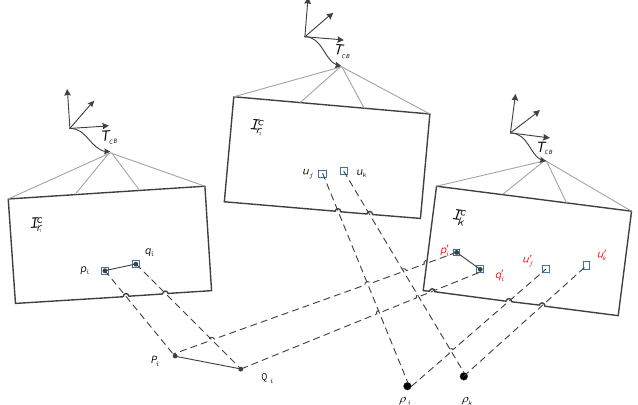
Figure 5. The 2D position of each point is individually optimized to minimize photometric errors in its image block. For line segments, the endpoints are similarly